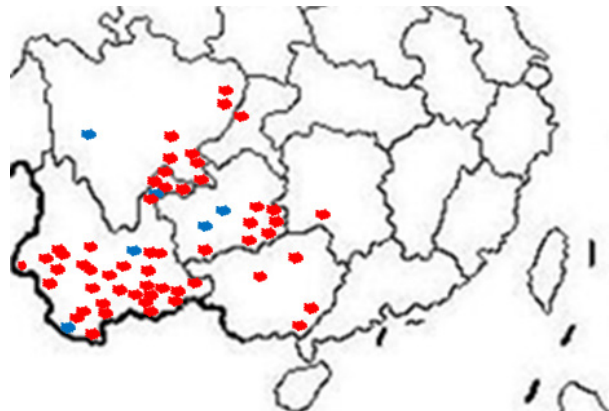
Figure 3. Distribution of SRBSDV infection in China (2011). Red indicates the samples infected with SRBSDV, the blue ones represent those uninfected.